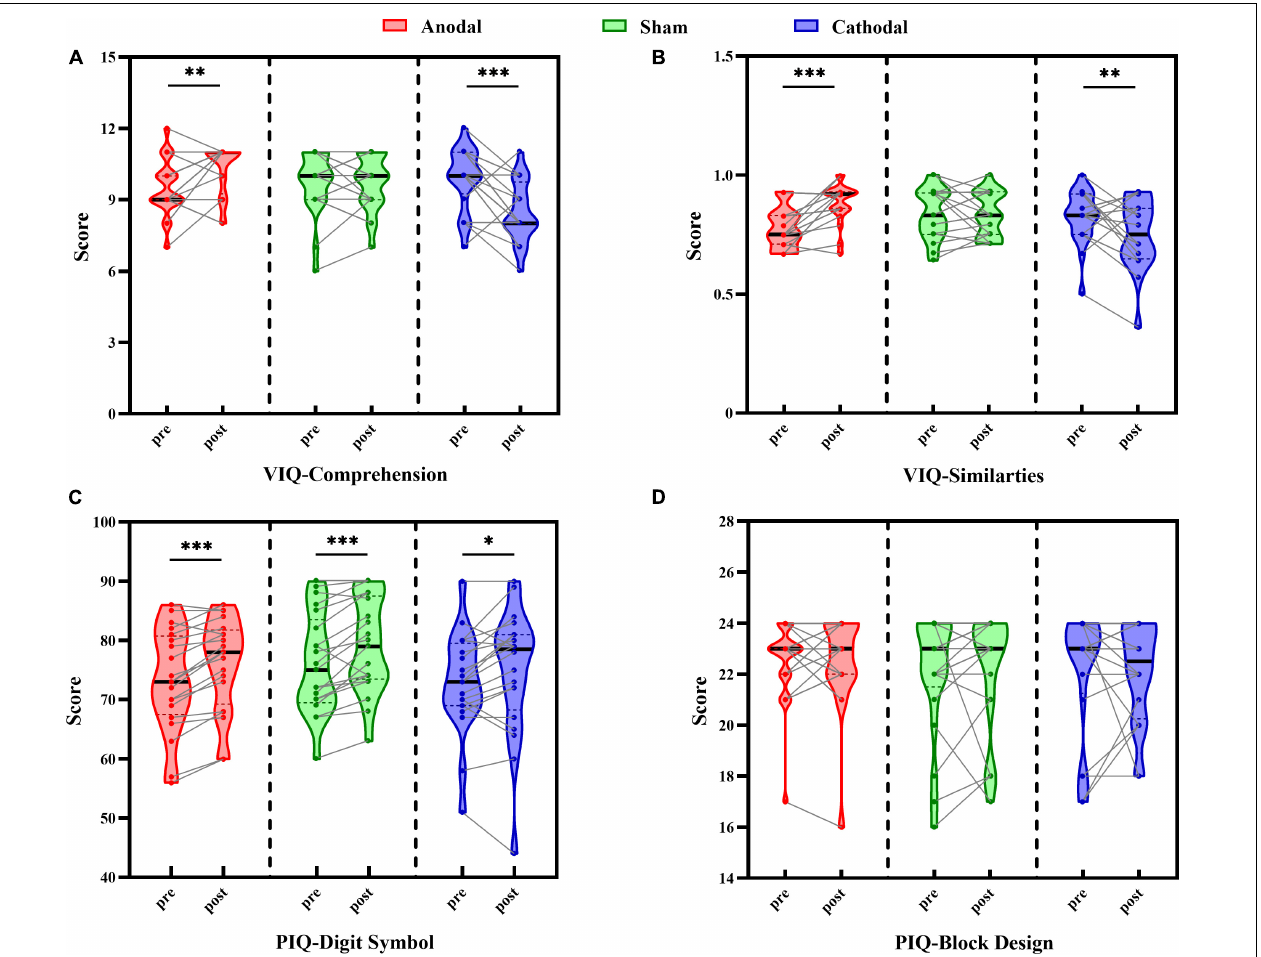
FIGURE 2 | Comparison between pre-test and post-test scores under each tDCS condition (anodal, cathodal, and sham) in Comprehension subtest (A) , Similarities subtest (B) , Digit Symbol subtest (C) , and Block Design subtest (D) . Individual participant data points, densities, medians, and quartiles are displayed, ∗ p < 0.05, ∗∗ p < 0.01, ∗∗∗ p <